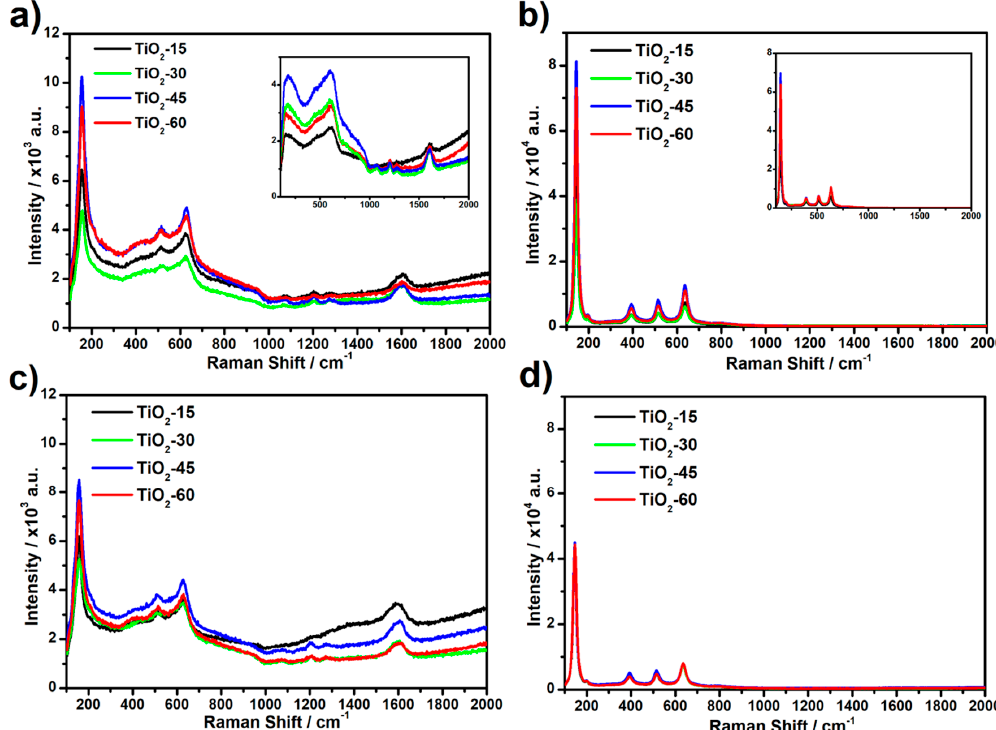
Figure 3. Raman spectra recorded for laser modified TiO 2 NTs: ( a ) as-anodized in air, ( b ) calcined in air, ( c ) as-anodized in vacuum, and ( d ) calcined in vacuum. Insets presented in Figure 3a,b represent unmodified titania samples: amorphous and calcined, respectively.